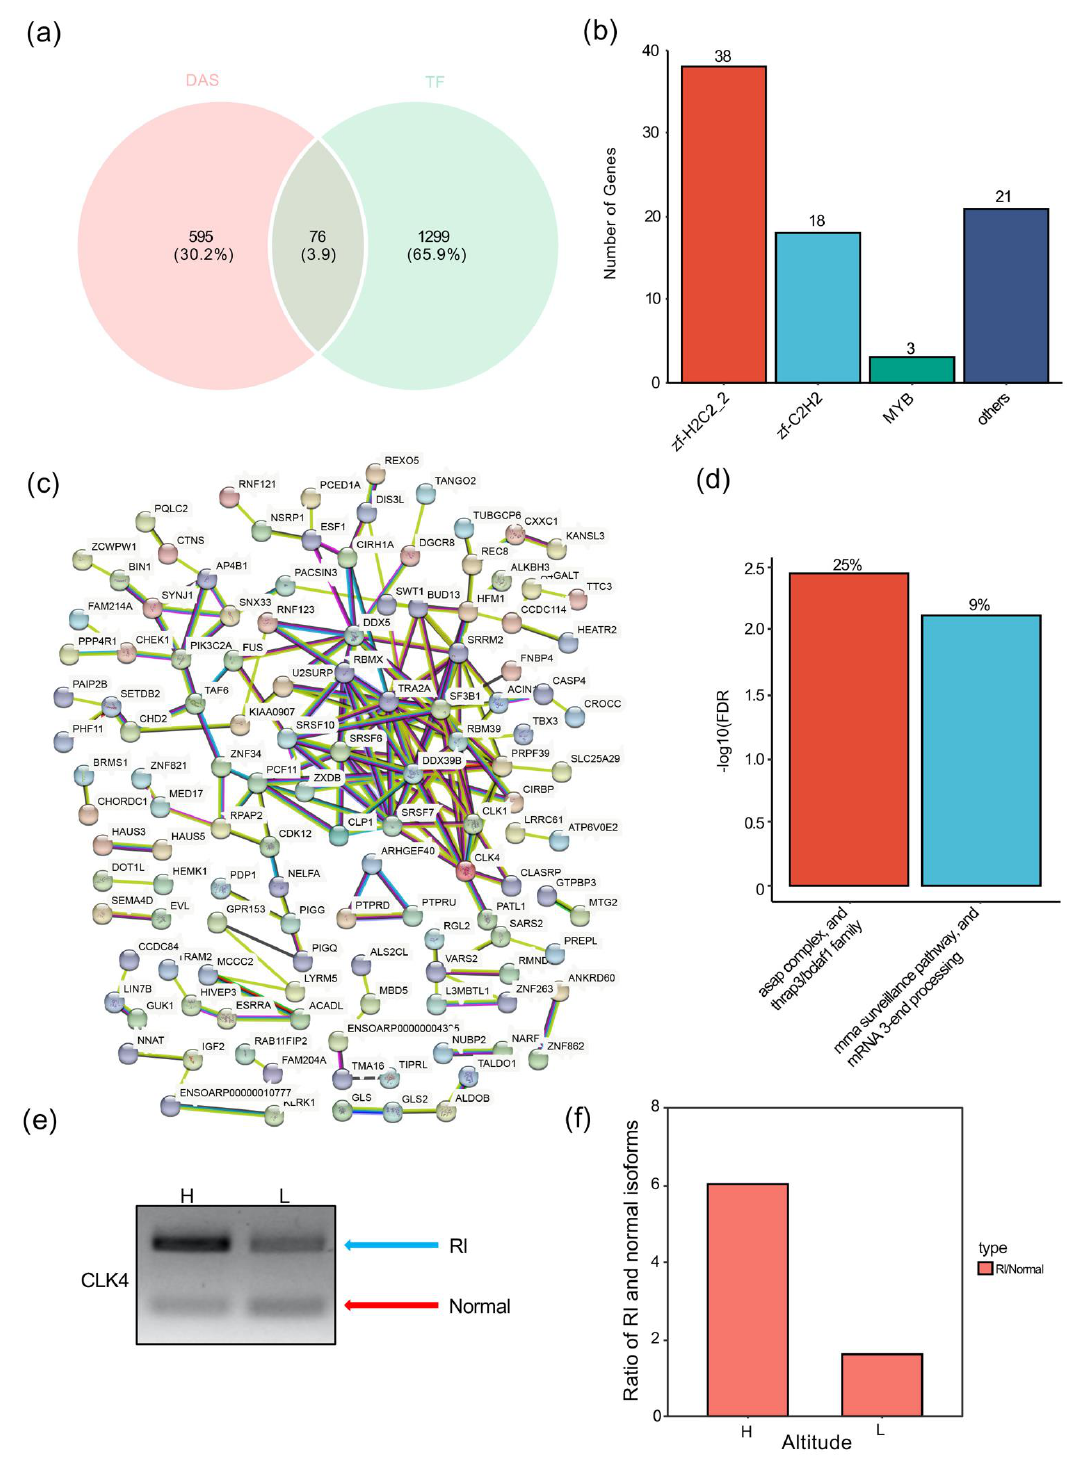
Figure 4. High-altitude stress-induced DAS genes mainly enriched in C 2 H 2 transcription factors and splicing factors. ( a ) The Venn diagrams indicate overlaps among DAS genes and TF genes. ( b ) The distribution of alternatively spliced TF genes. ( c ) The PPI network of DASs. ( d ) The functional enrichment clusters in the retained intron type of PPI network. ( e ) Expression of retained intron (RI) transcripts and normal transcripts (Normal) by RT-PCR. ( f ) The ratio between RI transcripts and normal transcripts with the gray value calculated with Gel-Pro Analyzer